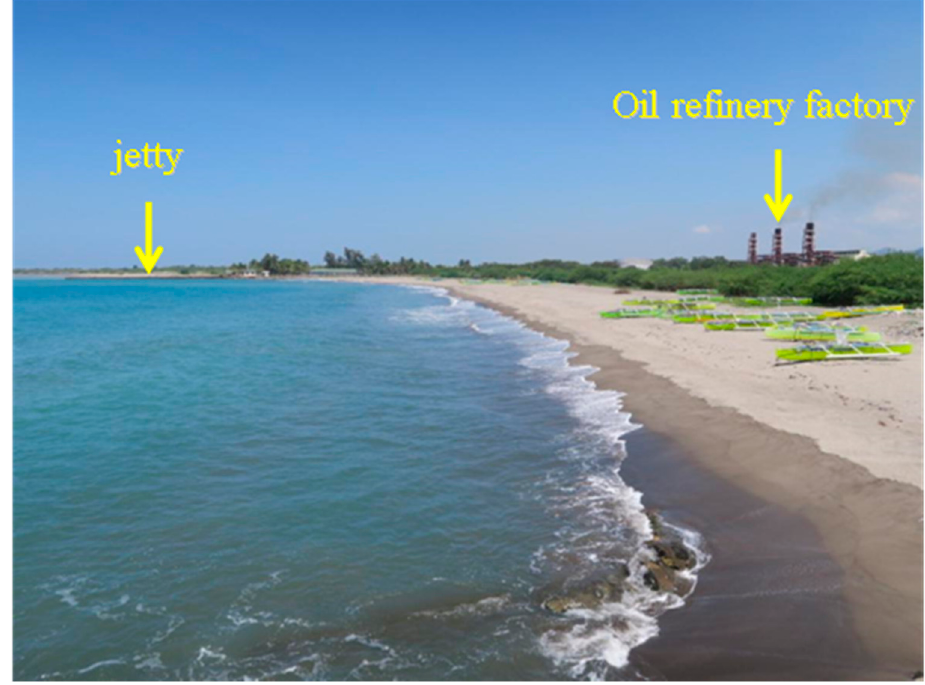
Figure 9. North view from the second floor of a damaged building.